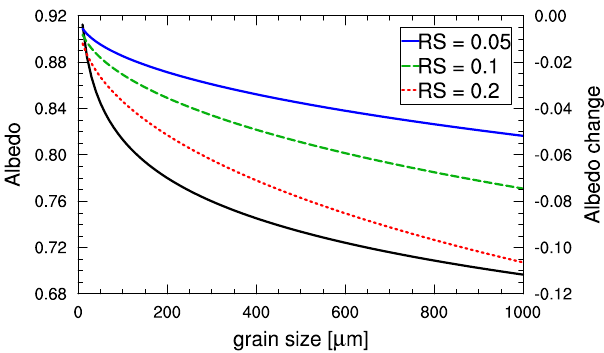
Fig. 4. Snow albedo as function of grain size (black, left axis) and the change of albedo as function of grain size for three different concentrations of black carbon in the snowpack: 0.05ppmv (blue, right axis), 0.1ppmv (green) and 0.2ppmv